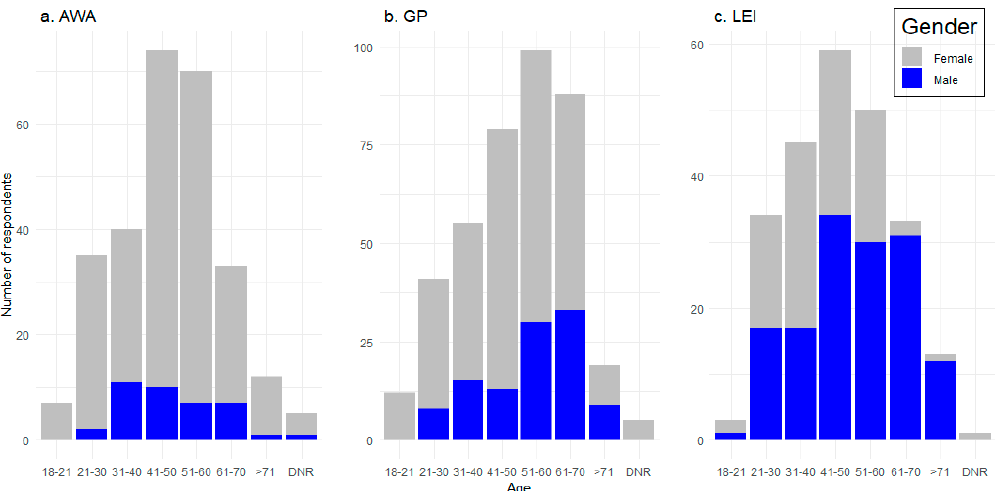
Figure 2. Age and gender of respondents classified as ( a ) animal welfare advocates (AWAs), ( b ) the general public (GP) or ( c ) live export industry (LEI) workers.